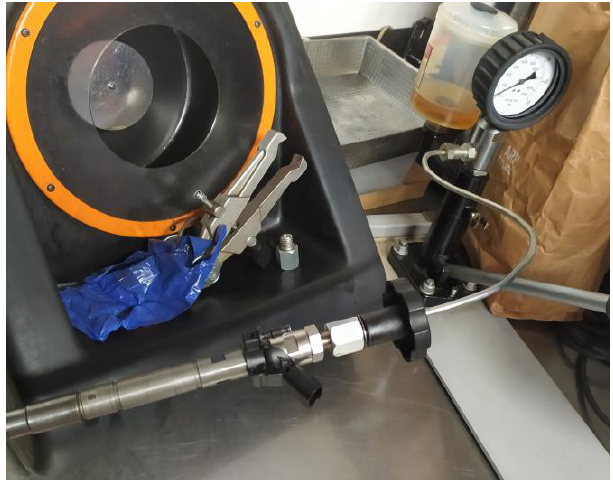
Fig. 5. The fuel injector leak test on the Bass BP-3605 tester